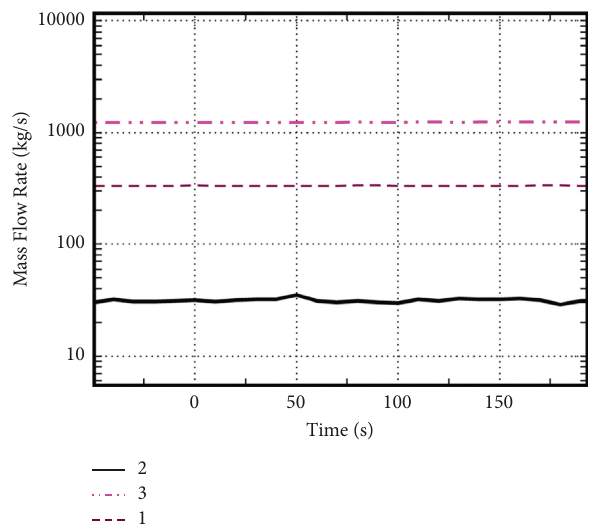
Figure 10: Fluctuations in the flow rate of the coolant in the circuits of heat removal from the core at a power of 50MW: 1, coolant flow in the I circuit; 2, coolant flow rate in the secondary circuit; 3, coolant flow rate in the heat transfer circuit to the final heat